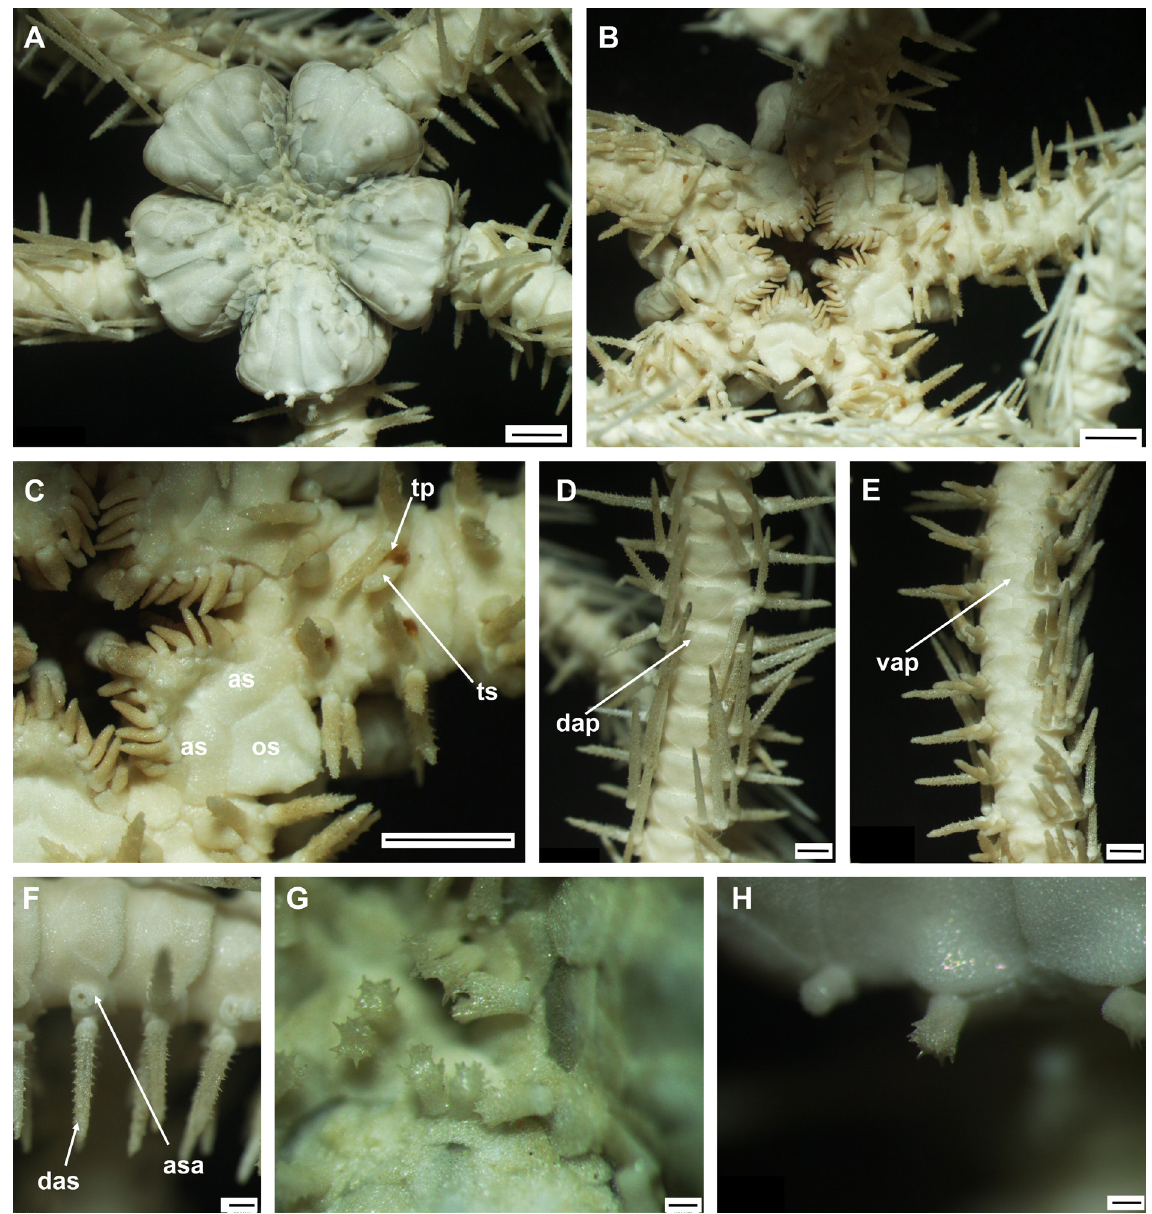
Fig. 25. Ophioplinthaca plicata (Lyman, 1878) (IDSSE EEB-SW0019). A . Dorsal disc. B . Ventral disc. C . Oral frame. D . Dorsal arm. E . Ventral arm. F . Lateral arm. G–H . Disc spine on the dorsal disc and distal end of the radial shields. Abbreviations: as = adoral shield; asa = arm spine articulation; dap = dorsal arm plate; das = dorsal arm spine; os = oral shield; tp = tentacle pore; ts = tentacle scale; vap = ventral arm plate. Scale bars: A–C = 2 mm; D–E = 1 mm; F = 500 µm; G–H = 200